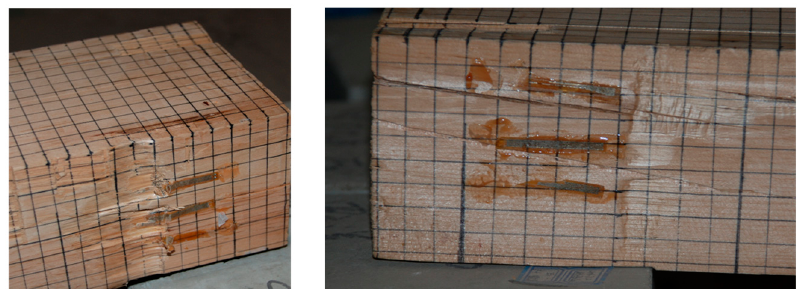
Figure 18. Pulling-out of the tenon.